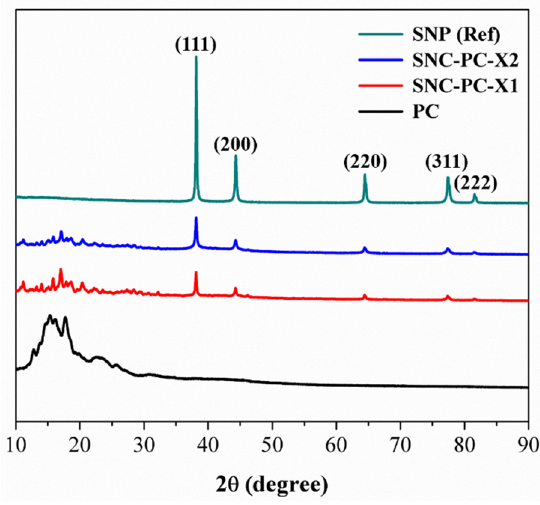
Figure 5. XRD di ff ractogram of PC, SNC-PC-X1 and SNC-PC-X2 with reference Figure 5. XRD diffractogram of PC, SNC-PC-X1 and SNC-PC-X2 with reference SNPs.